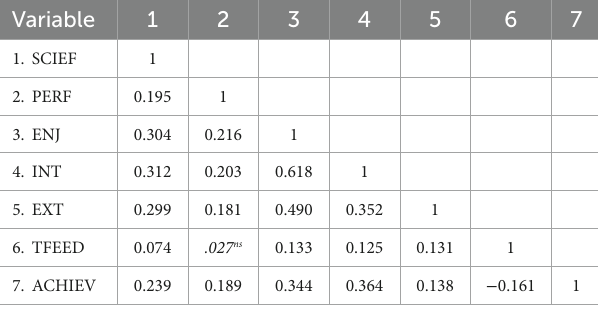
TABLE 3 Model estimated correlation matrix.